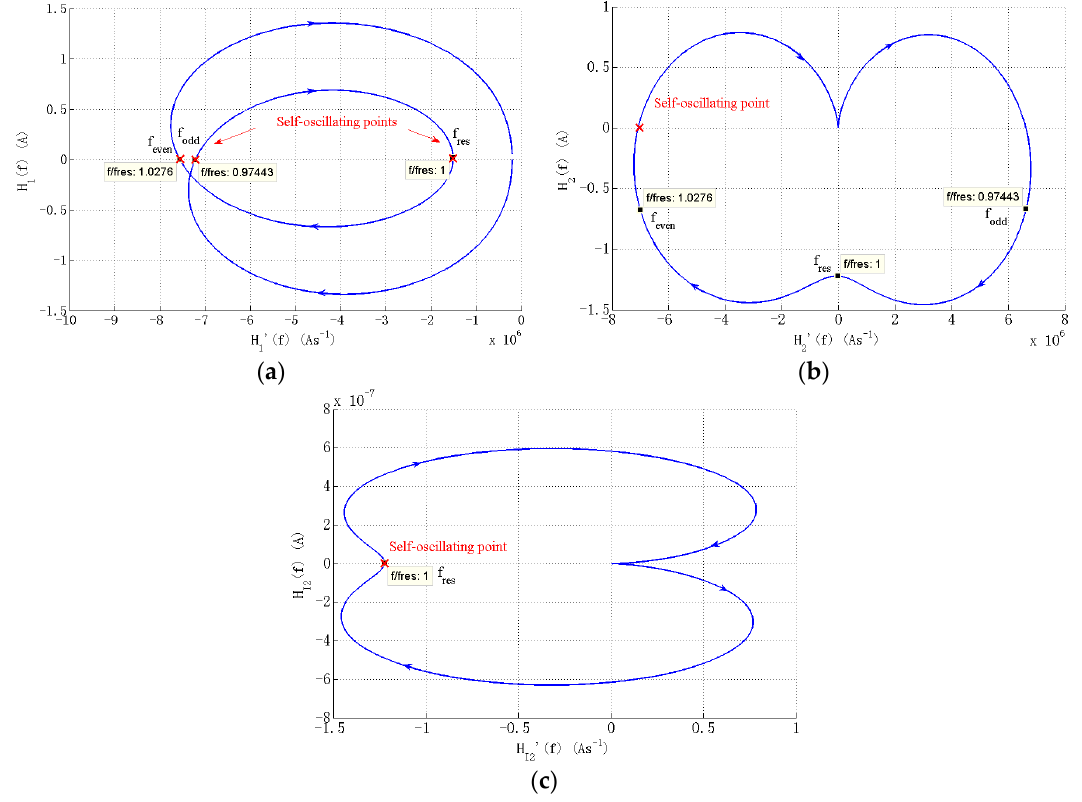
Figure 4. Hamel loci of different feedback methods: ( a ) feedback variable i 1 ; ( b ) feedback variable i 2 ; and ( c ) feedback variable i 2 with an integrator.